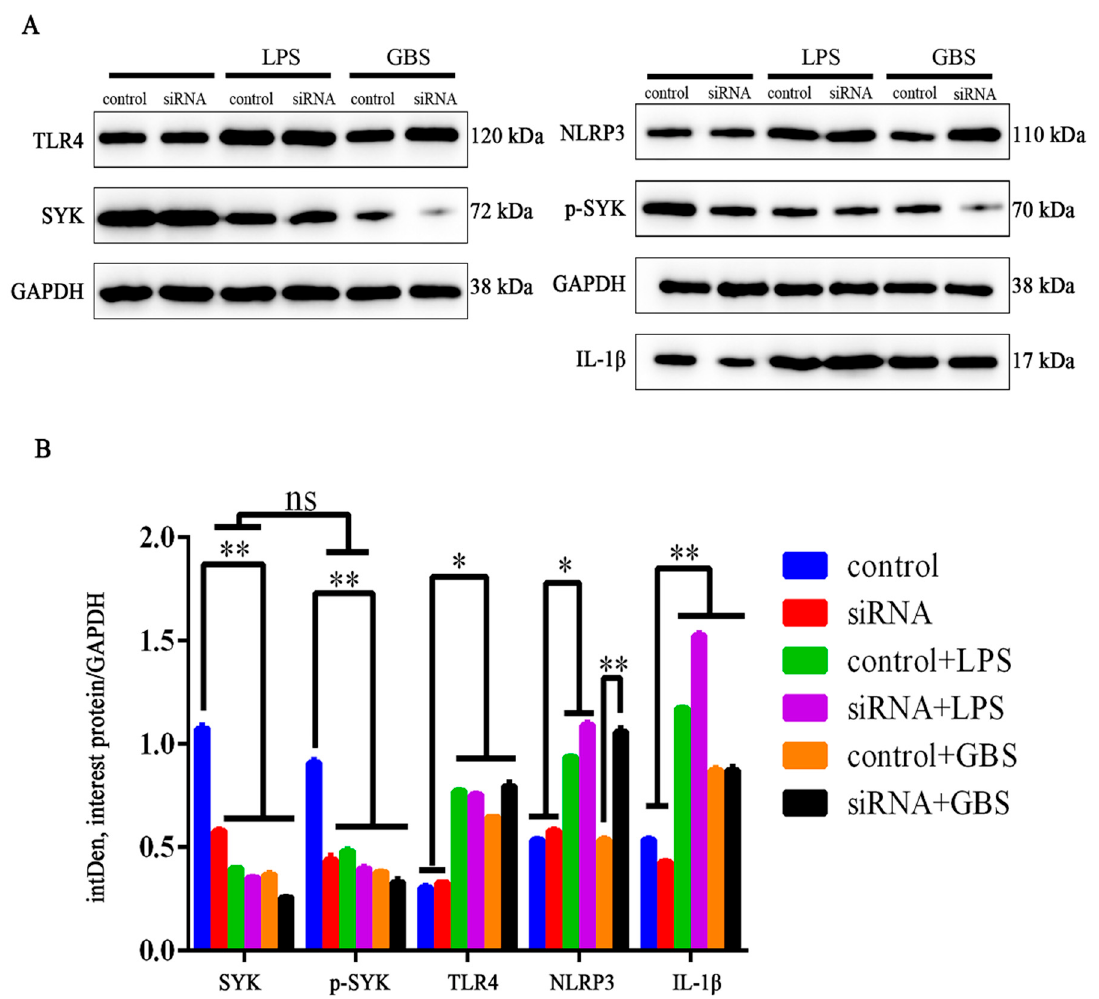
Figure 7. SYK, TLR4, IL-1 and NLRP3 protein levels in bMECs and bMECs SYK- with LPS or GBS (30 min). ( A ) TLR4, SYK, p-SYK, IL-1 β and NLRP3 protein levels were detected in bMECs and bMECs SYK- with LPS or GBS via the WB method; ( B ) the relative quantitative method of intDen value to calculate the difference of TLR4, SYK, p-SYK, IL-1 β and NLRP3 protein levels in bMECs and bMECs SYK- . * p < 0.05, ** p < 0.01, ns = no difference.